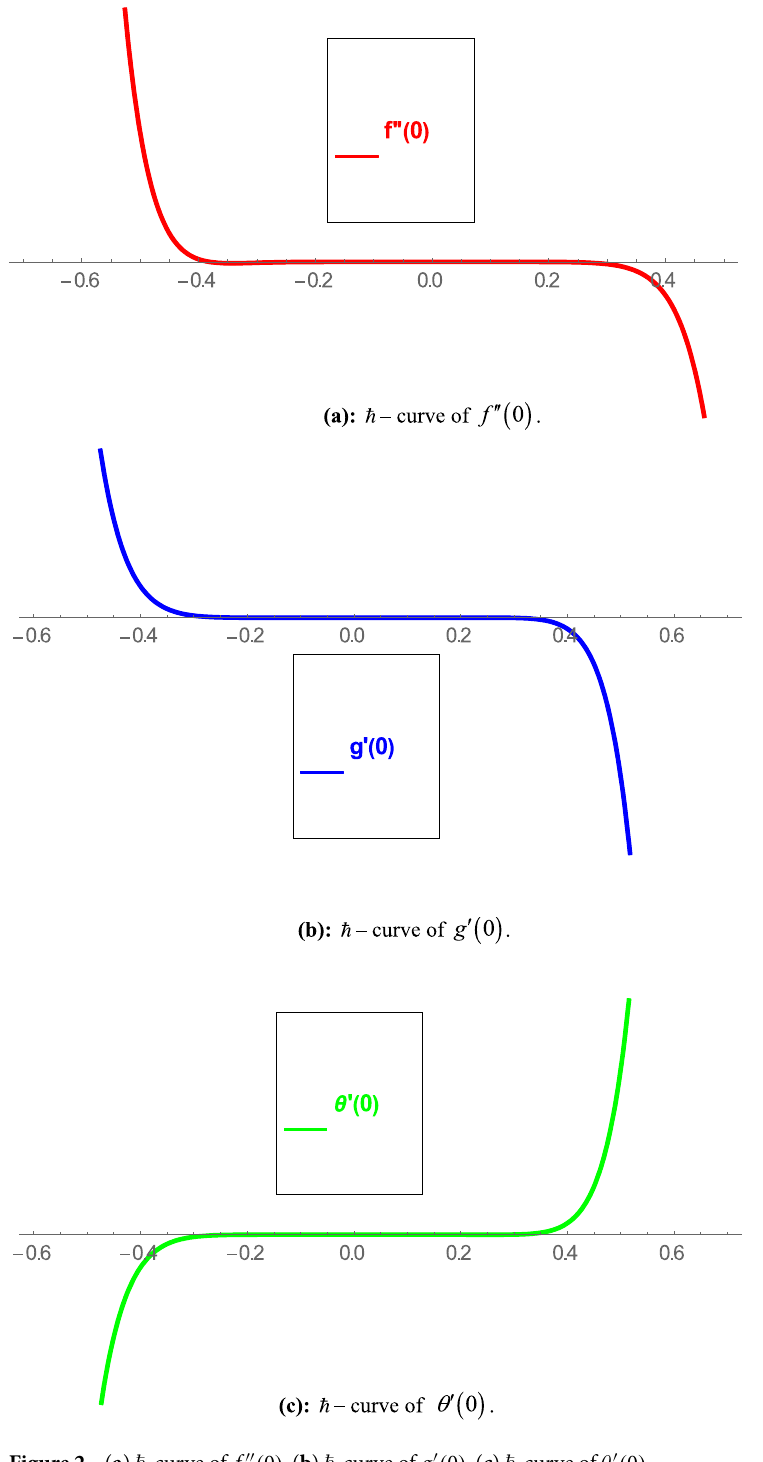
Figure 2. ( a ) (cid:31) -curve of f ′′ ( 0 ) . ( b ) (cid:31) -curve of g ′ ( 0 ) . ( c ) (cid:31) -curve of θ ′ ( 0 )